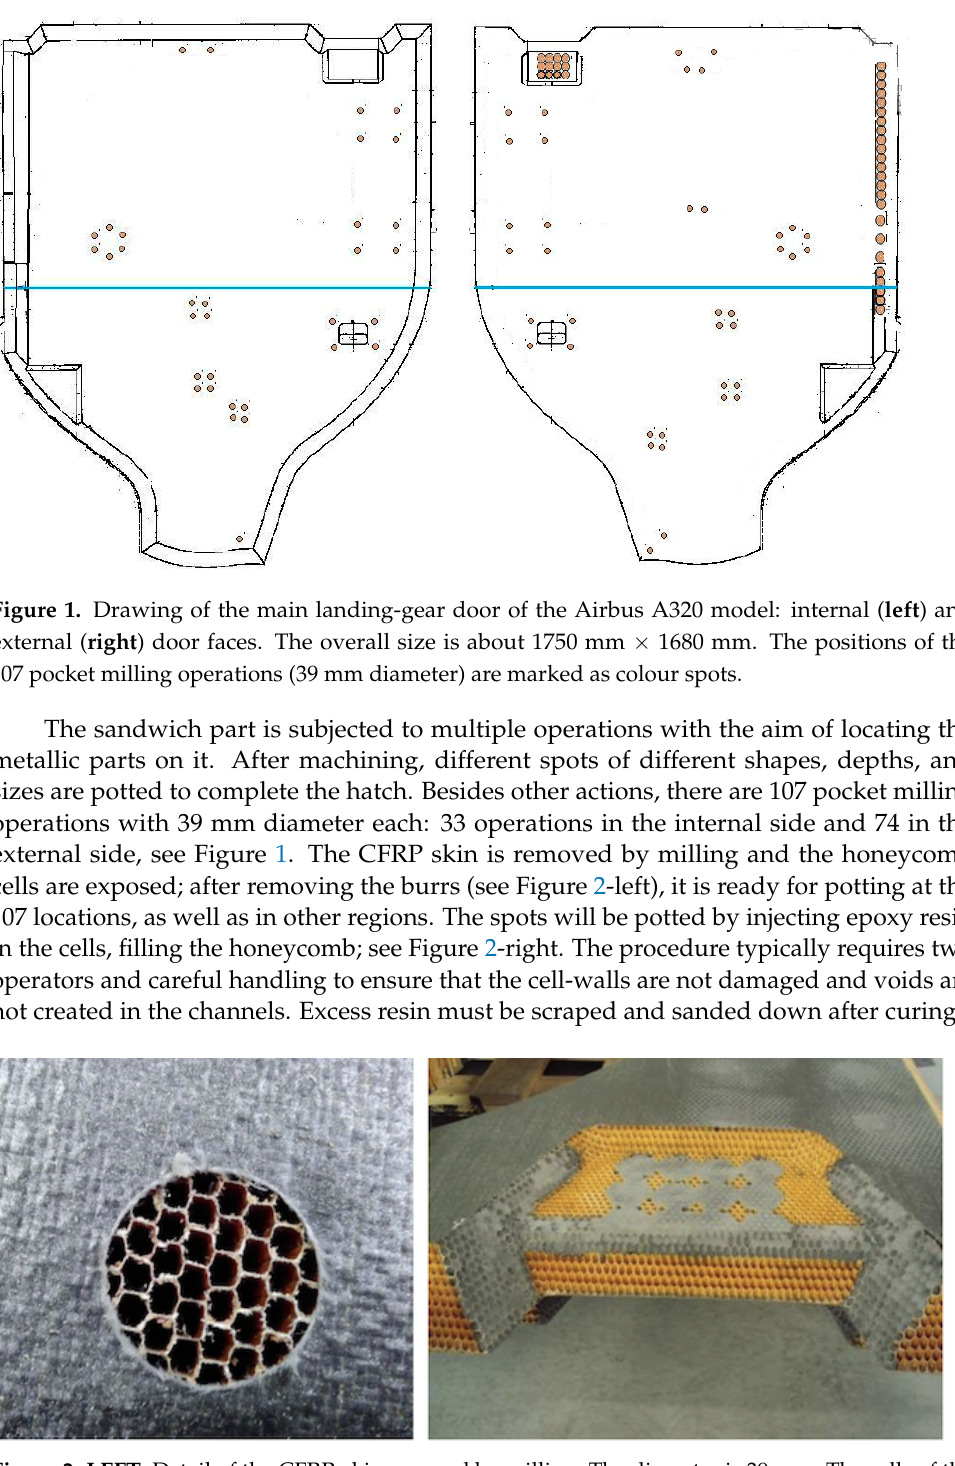
Figure 2. LEFT : Detail of the CFRP-skin removal by milling. The diameter is 39 mm. The cells of the core are visible and clean of burrs, ready for potting. RIGHT : Detail of the potting of one section corresponding to the upper part of the outer-side of the door. The core has been previously machined. The round spots as well as some sides of the honeycomb are then